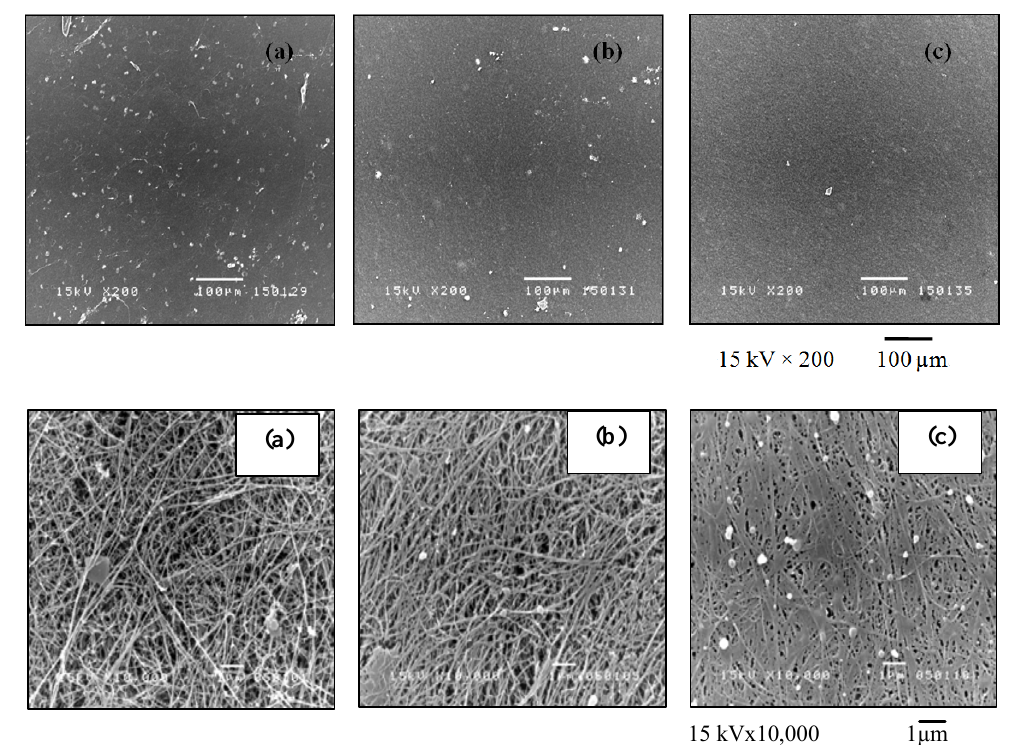
Figure 1. The overview (top) and high magnification (bottom) photomicrographs of the bacterial cellulose (BC) and bacterial cellulose gelatin (BCG) films: ( a ) BC; ( b ) BCG-3 and ( c )